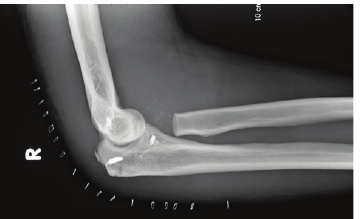
Figure 2: Postoperative X-ray: lateral view showing medial collat- eral ligament and triceps tendon reconstruction with radial head excision. Table 1: Summary of elbow function at 3-year